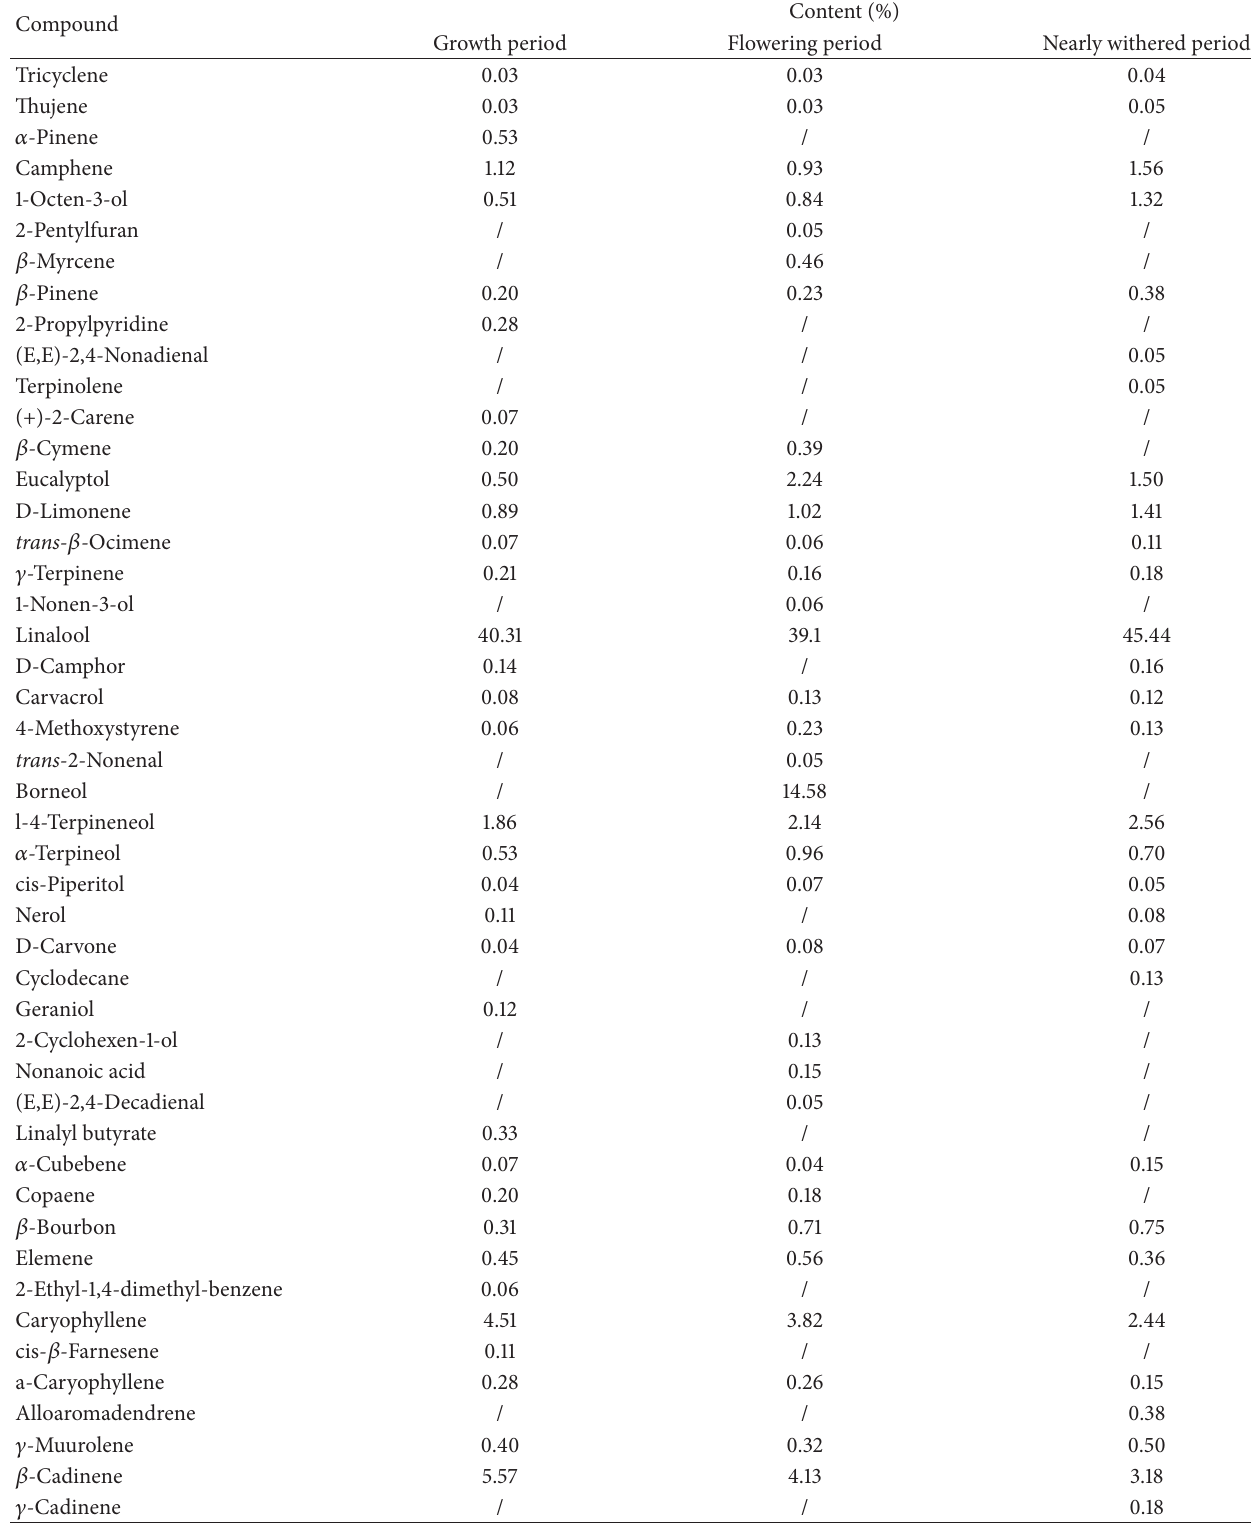
Table 2: Constituents of essential oil of T. quinquecostatus in different